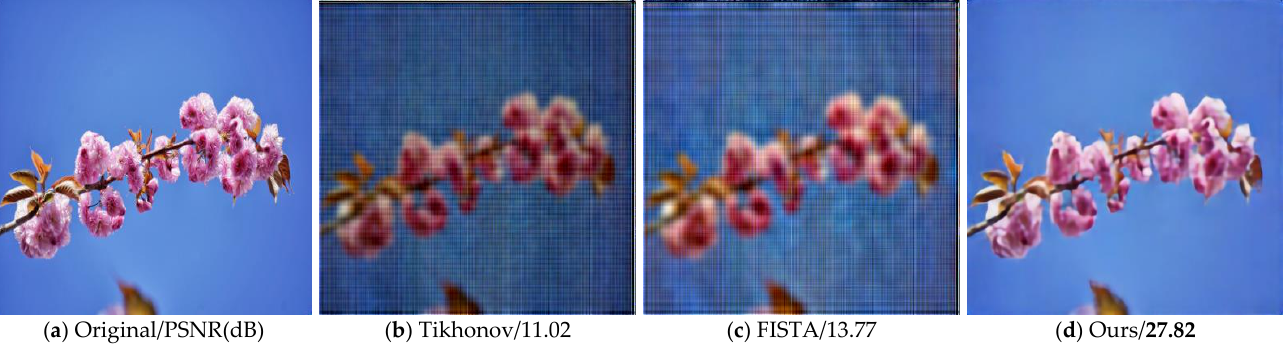
Figure 10. FlatCam imaging results on 0898.png of DIV2K dataset. ( a ) The original image. ( b ) The result of Tikhonov. ( c ) The result of FISTA. ( d ) Our result. Table 7. The average PSNR and SSIM values of 100 images in DIV2K’s valid